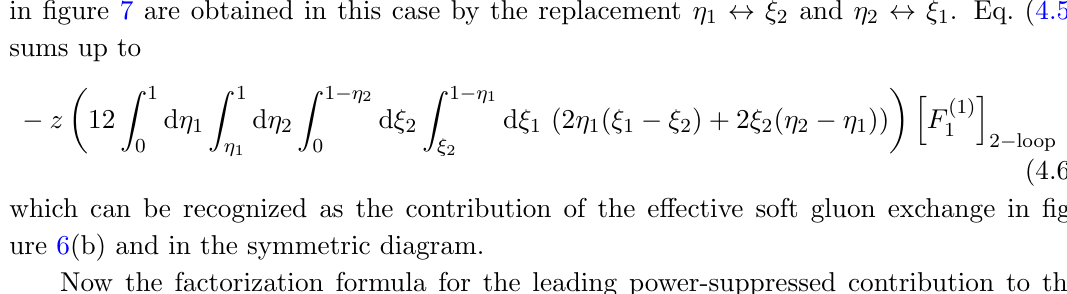
where c (1) and w (1) are listed in table 4. The weights for the symmetric diagrams not (cid:21) (cid:21)